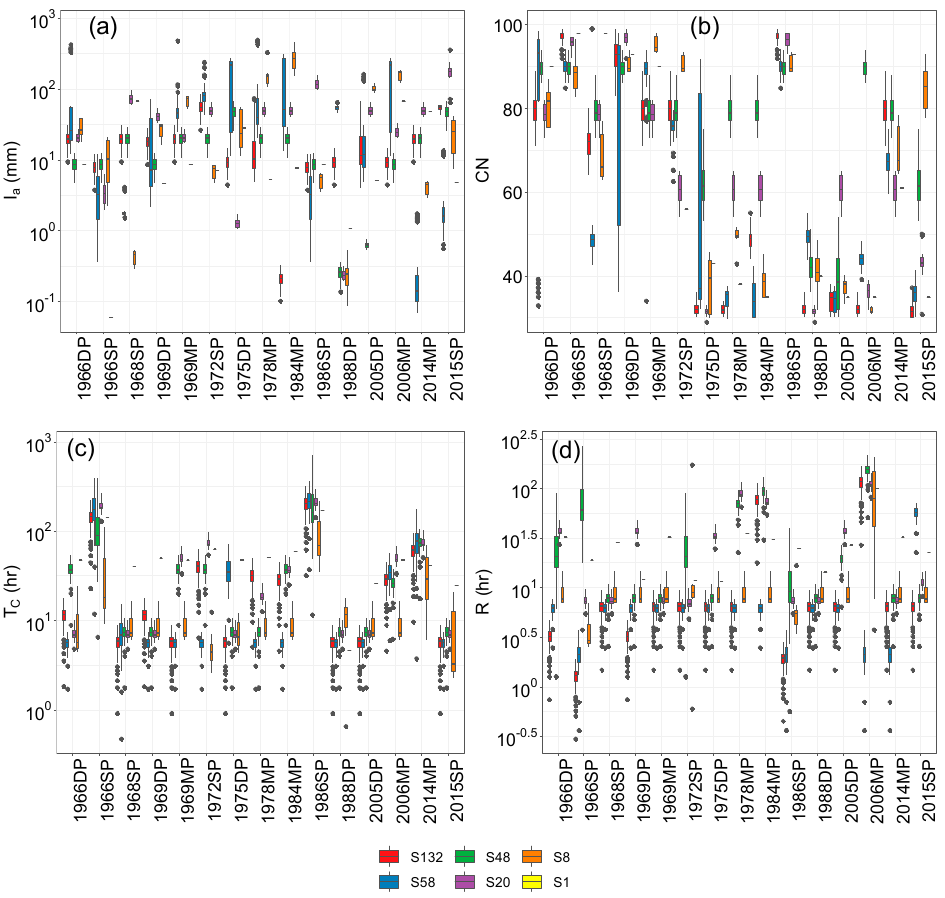
Figure 5. Boxplots show the calibrated parameter values of all basins of six configurations for each of the 15 events. Events were sorted as per their year of occurrence. Boxplots of red, green, orange, blue, purple and yellow colors correspond to S132, S48, S8, S58, S20 and S1, respectively. The letters in the event name, i.e., SP, DP and MP, correspond to single peak, double peak and multiple peak flood events. Panels in the clockwise direction from the top left, ( a – d ) correspond to I a , CN, T c and R,